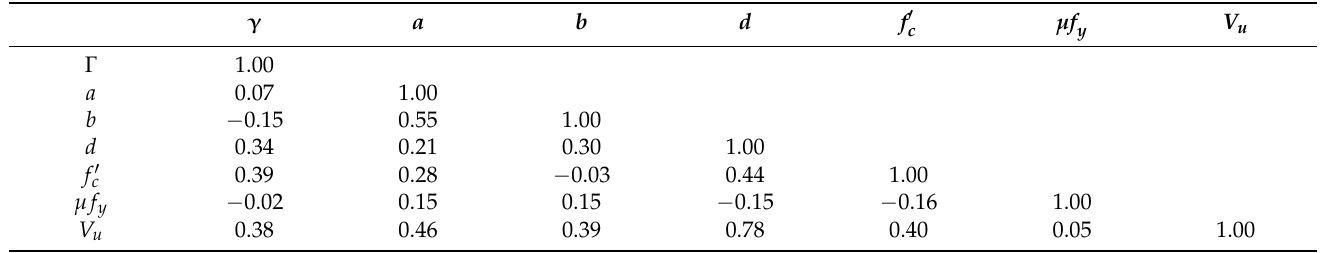
Table 3. Pearson correlation